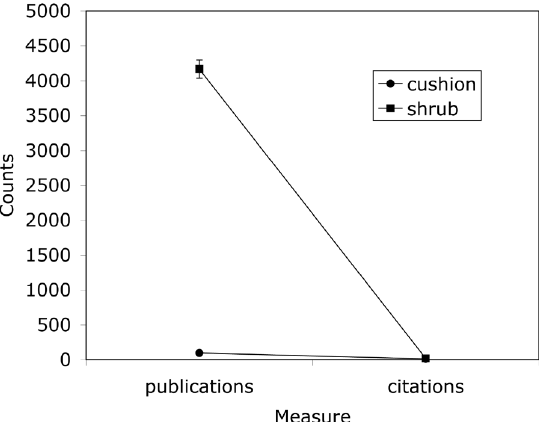
Figure 1. Number of publications and citations from an ISI Web of Science search for ‘cushion plant’ and ‘shrub’. Error bars de- note ± 1